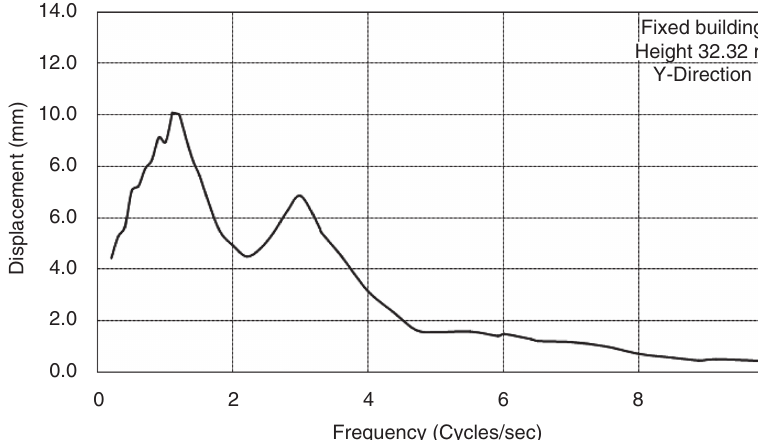
Fig. 11. Spectral Displacement in Y-direction ( fi xed building)